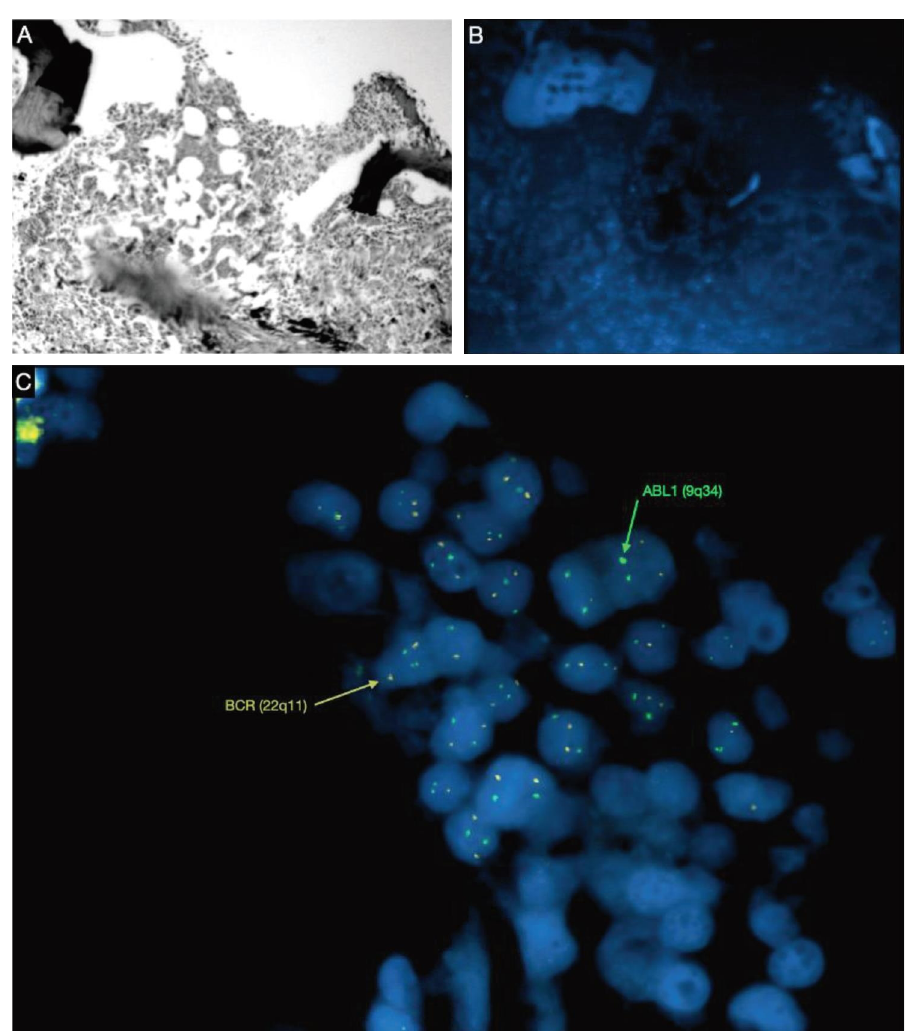
Figure 1: (a): IHC ( × 10), (b): FISH ( × 10), and (c): FISH ( × 100); a fuorescence in situ hybridization (FISH) technique for the detection of the t (9; 22) ( q 34; q 11) reciprocal translocation was performed in samples with mast cell infltration and was